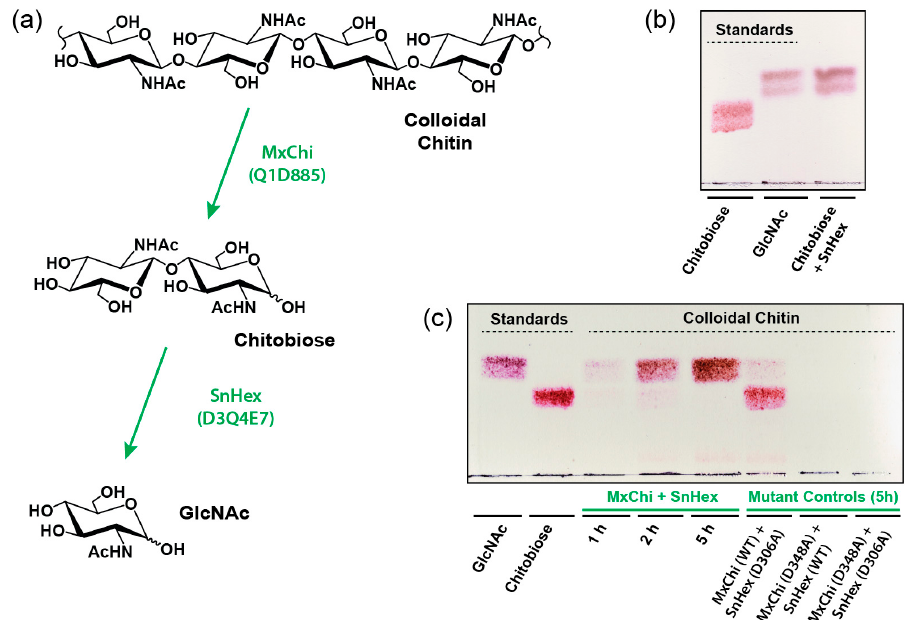
Figure 4. Enzymatic degradation of colloidal chitin. ( a ) Schematic overview of the action of MxChi and SnHex on colloidal chitin and chitobiose substrates. ( b ) TLC analysis using chitobiose as a substrate for the enzymatic hydrolysis to GlcNAc by SnHex. ( c ) TLC analysis using colloidal chitin as the substrate after incubation with both MxChi and SnHex, which yields the enzymatic hydrolysis product GlcNAc. The two bands in each analysis plate results from the α -anomers and β -anomers of chitobiose and GlcNAc. TLCs were developed with a mobile phase containing n-butanol:methanol:water at a ratio of 5:3:2 and were stained with